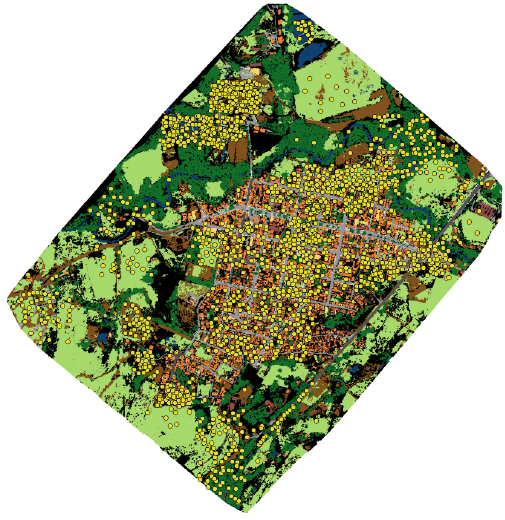
Figure 8. Classified Images - Test 12. (a)Step 1 and (b)Step